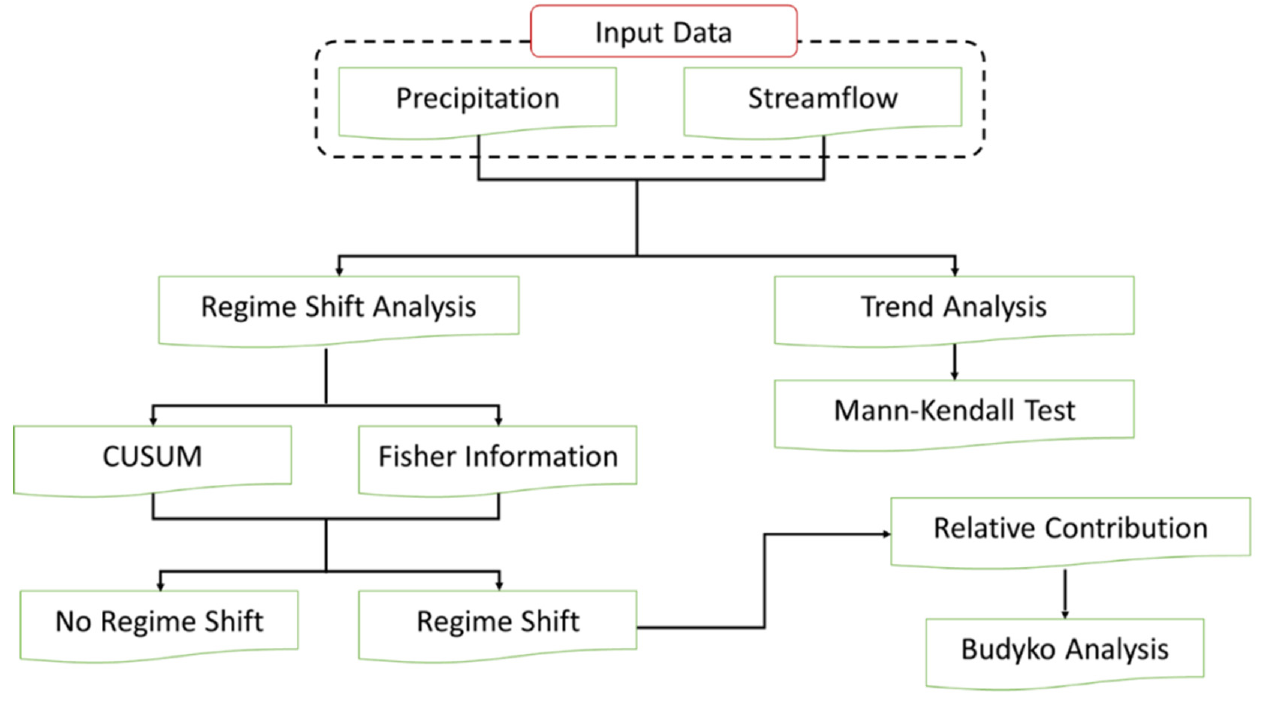
Figure 2. Methodological framework for identification of regime shifts and relative contribution analysis .